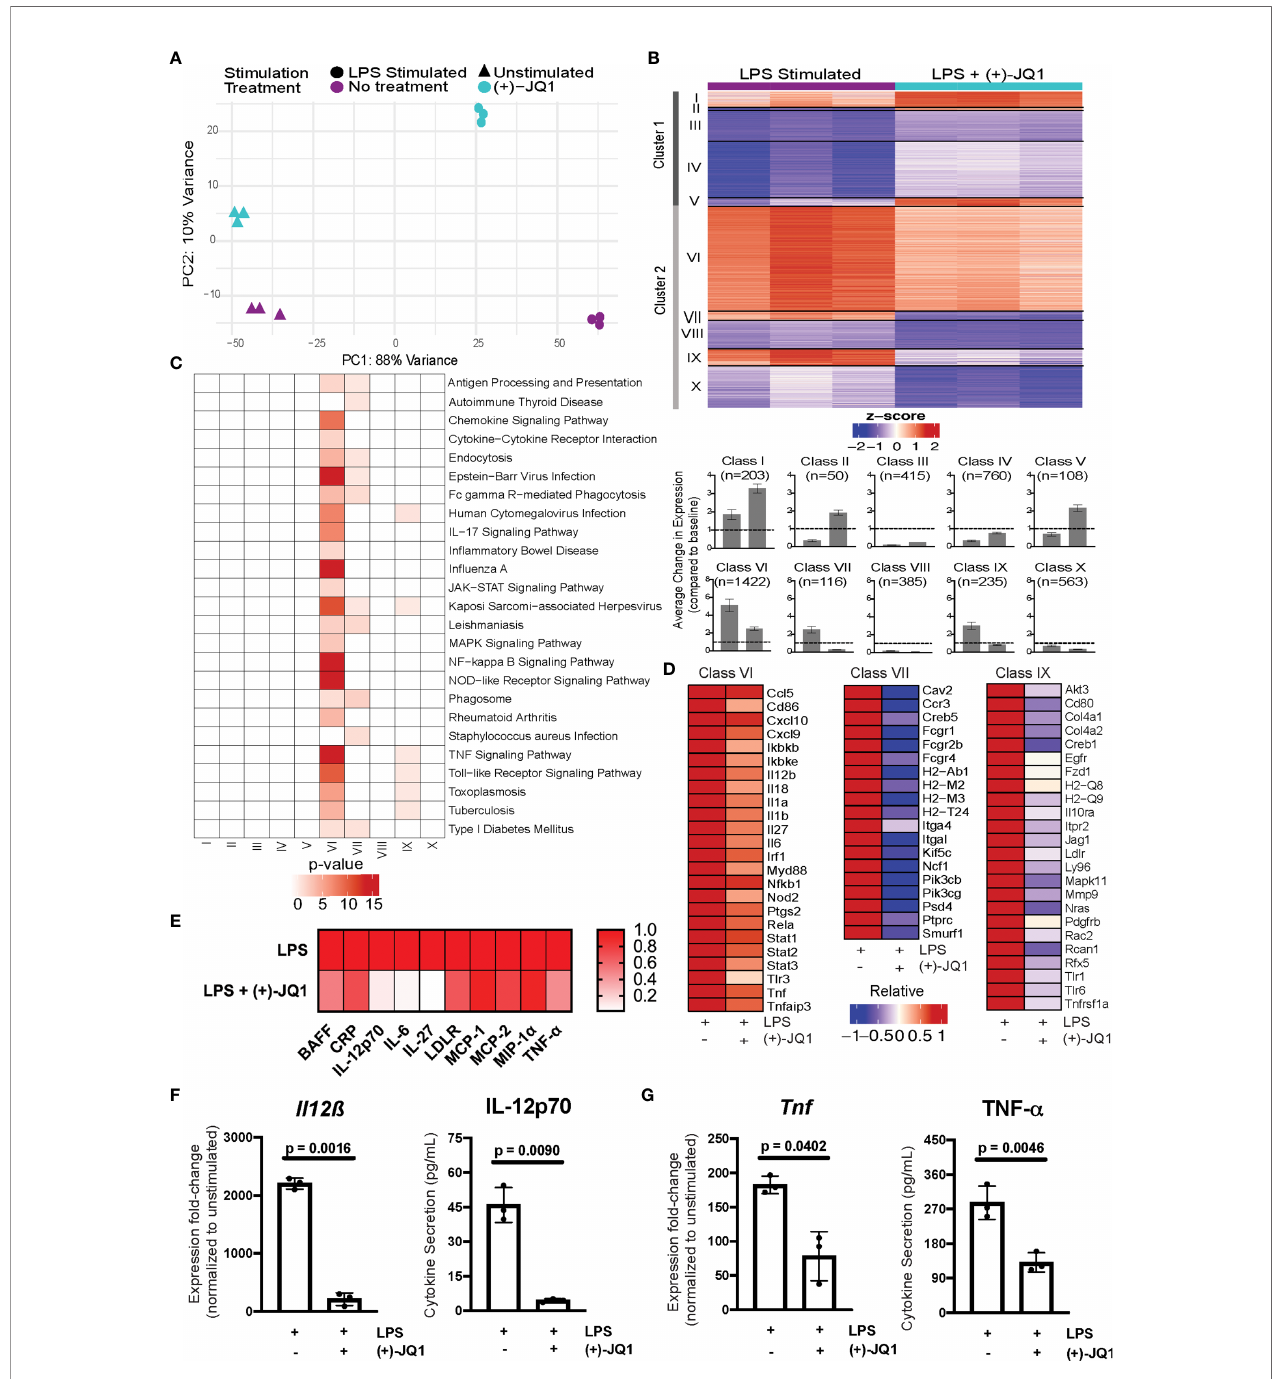
FIGURE 2 | (+)-JQ1 treatment attenuates LPS-induced in fl ammatory gene expression in Il10 -/- macrophages. (A) Principle component analysis (PCA) of gene expression pro fi les for samples that remained unstimulated (triangles) or were stimulated with LPS (circles) in the absence (purple) or presence (aqua) of (+)-JQ1. (B) Representative heatmap of calculated z-scores based on log 2 fold-change of individual replicates for the LPS and LPS + (+)-JQ1 conditions normalized to the average of unstimulated, untreated Il10 -/- BMDMs. Genes were identi fi ed and divided into 2 major clusters and sub-divided into 5 classes through differential analyses outlined in Supplementary Table 1 . Bar graphs represent average change in expression for LPS and LPS (+)-JQ1 conditions normalized to baseline. (C) KEGG pathway analysis for the genes identi fi ed in the 10 classes in (B) . (D) Heatmaps of representative genes from Classes VI, VII, and IX that correspond to genes induced by LPS that are attenuated with (+)-JQ1. (E) Heatmaps of representative in fl ammatory cytokines induced by LPS that are attenuated with (+)-JQ1. Gene expression (qRT-PCR; left panels) and cytokine secretion (Luminex; right panels) analyses for (F) Il12 b and IL-12p70, and (G) Tnf and TNF- a . Signi fi cance determined using paired parametric, student ’ s t tests. N = 3 biological